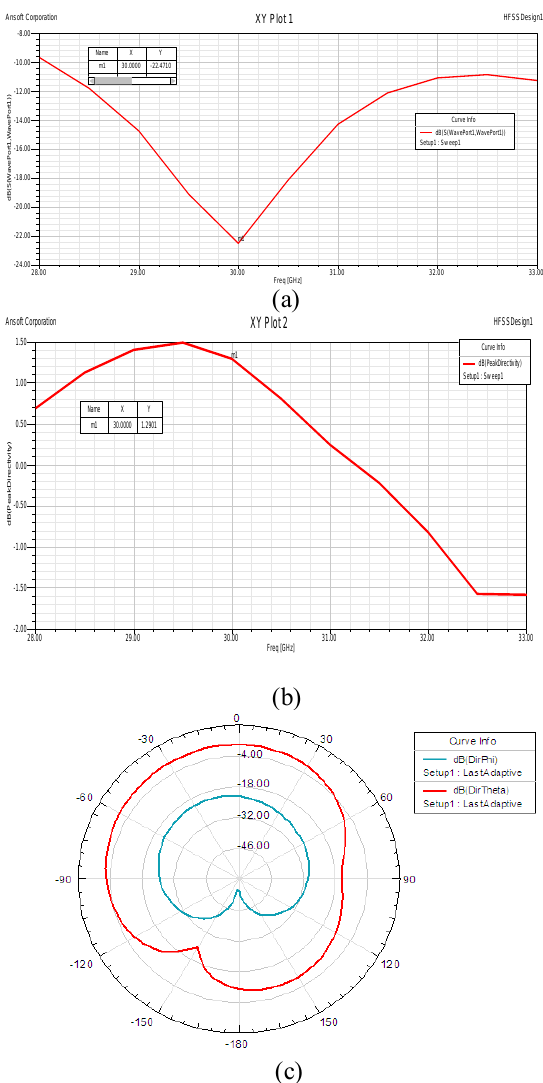
Figure 13 : Simulated (a) return loss (b) Peak directivity and (c) far-field radiation pattern of the patch antenna